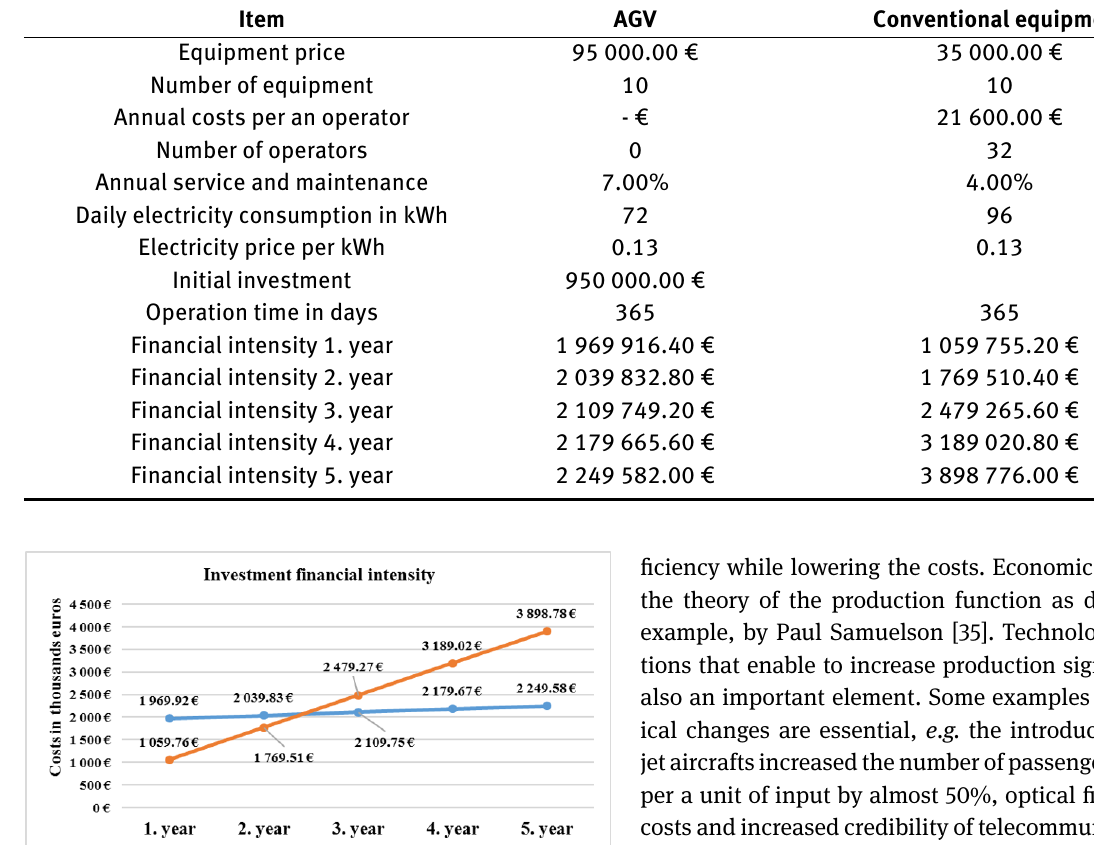
Table 3: Input data for the financial intensity calculation for the implementation of AGVs in the logistics warehouse. [authors]